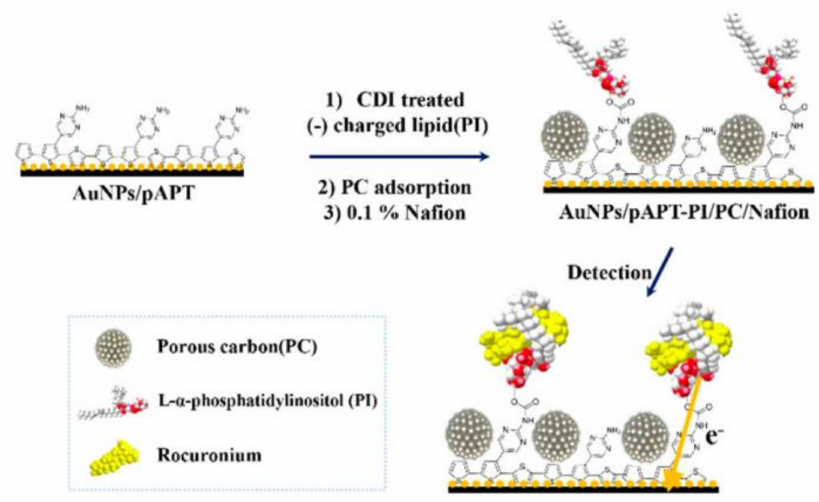
Figure 6. Schematic representation of the rocuronium sensor. Reprinted with permission from reference [216]. Copyright Wiley & Sons